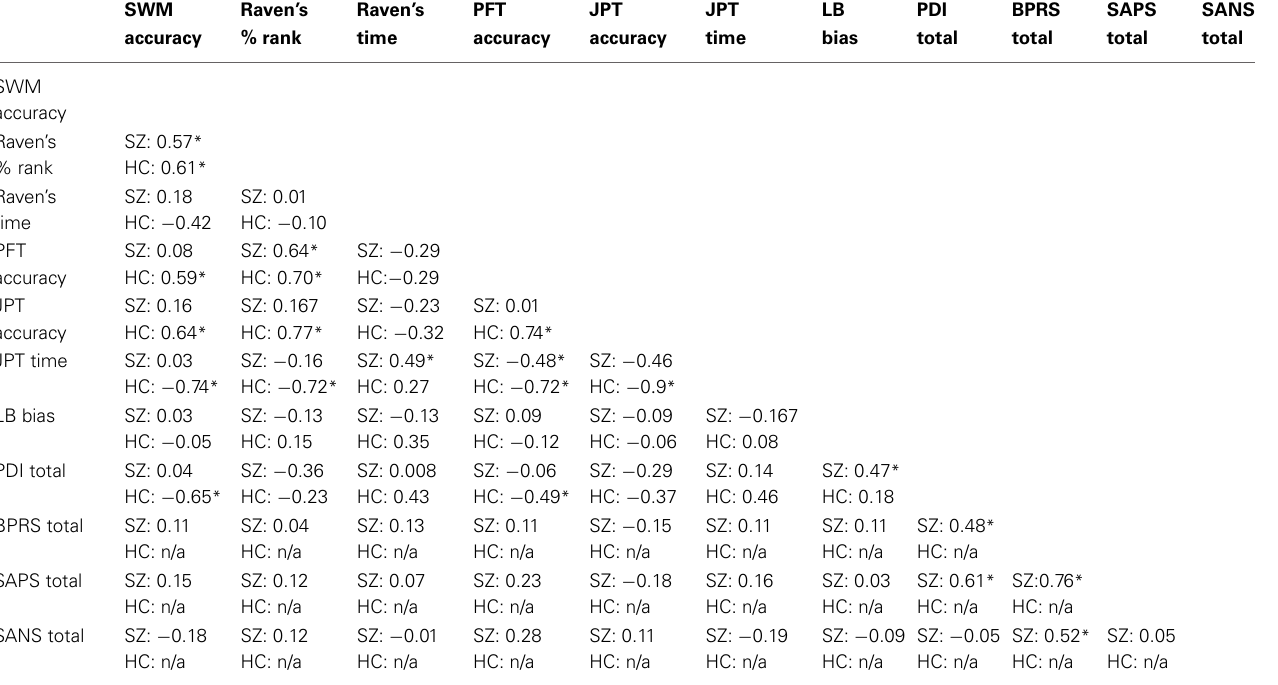
Table 3 | Spearman’s correlation matrix.